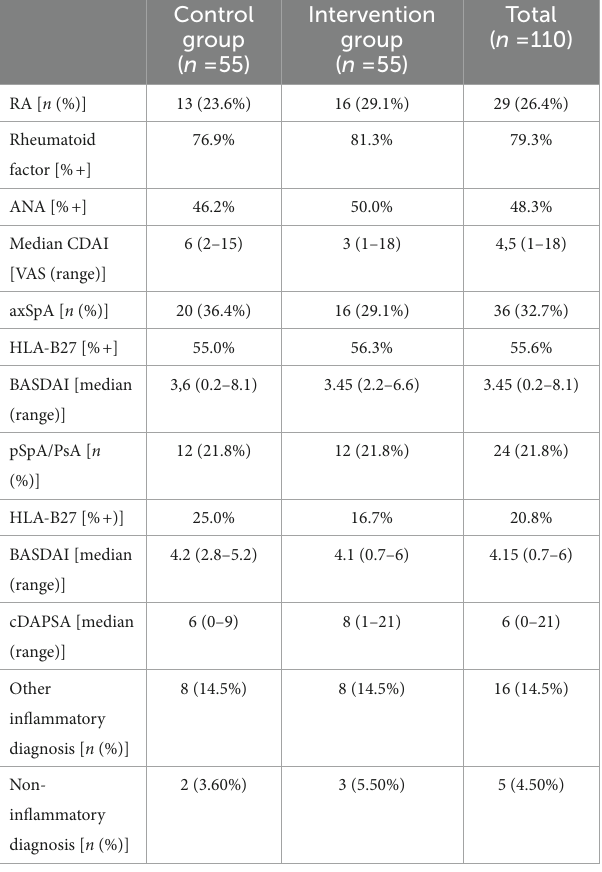
TABLE 2 Characteristics of disease groups at study entry (including laboratory data and assessments of disease activity with clinical scores as appropriate).